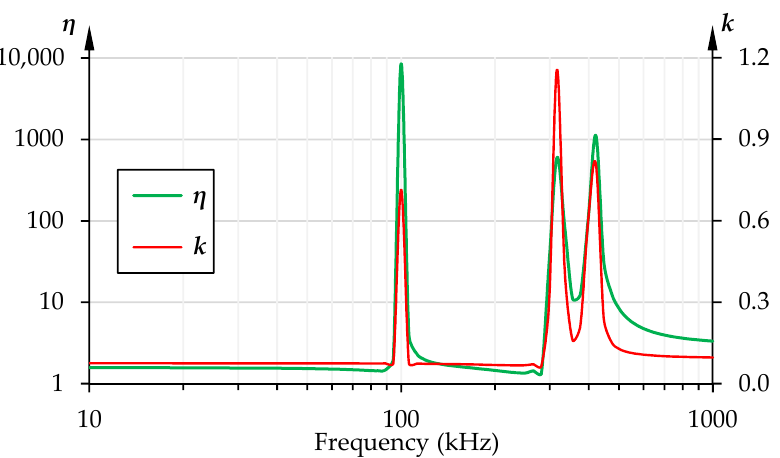
Figure 13. Frequency response of the magnetic meta-hose with the highest gain of energy transfer η ( ν = 0.15, µ m = 124) identified at f r = 100 kHz.